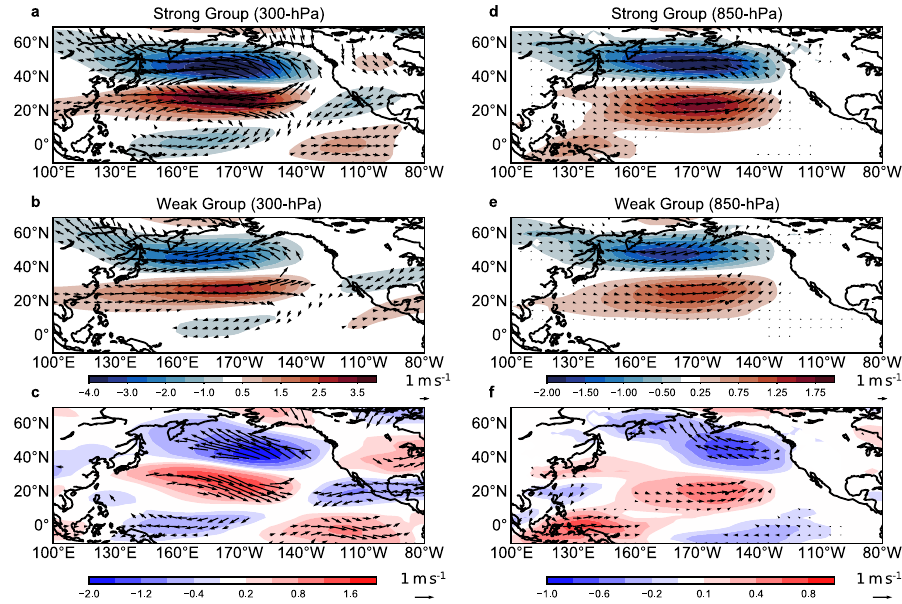
Fig. 4 Composite of zonal wind at 300 hPa (left) and 850 hPa (right) for the strong and weak MWAF groups. Composite difference of 300- hPa wind (vectors) and zonal wind anomalies (shading) between positive and negative NPO events for ( a ) strong group and ( b ) weak group. c The difference of 300-hPa wind anomalies between the strong and weak MWAF groups. d – f is the same as ( a – c ) but for 850-hPa wind anomalies. The vectors are shown only with the zonal wind above the 90% con fi dence